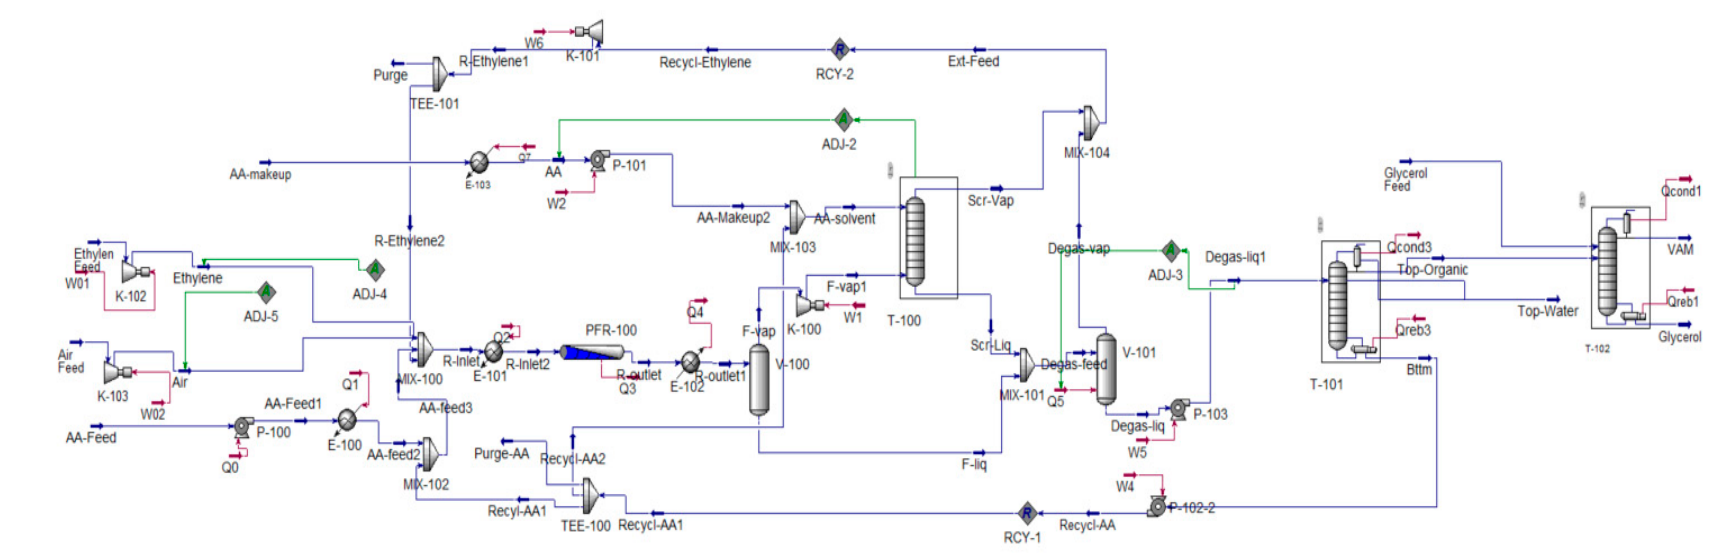
Figure 7. Aspen HYSYS simulation flowsheet of vinyl acetate production, adapted from [83]. AA: acetic acid.